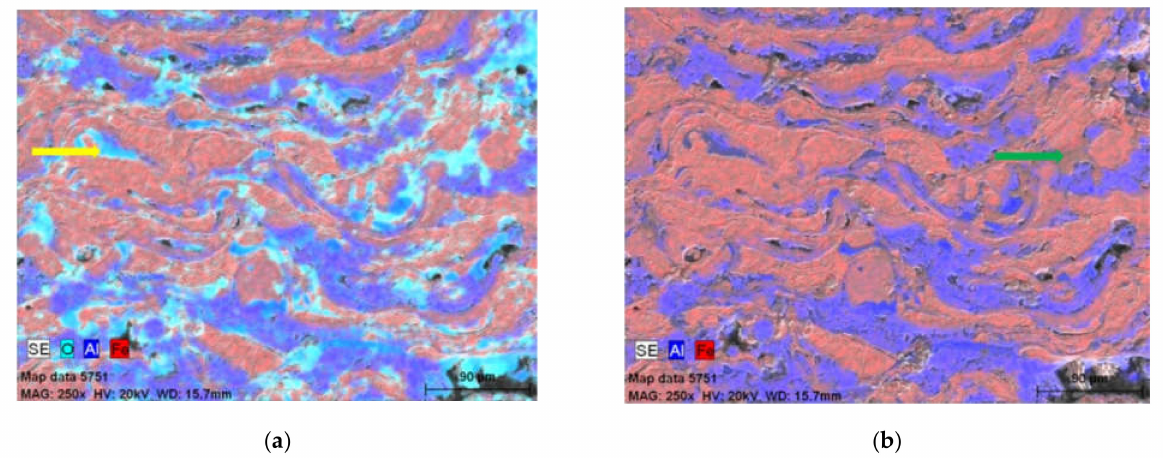
Figure 4. EDX maps of elemental distribution in cross-section of the Fe-Al-type coating annealed at 700 ◦ C: ( a ) O, Al, Fe; ( b ) Al,